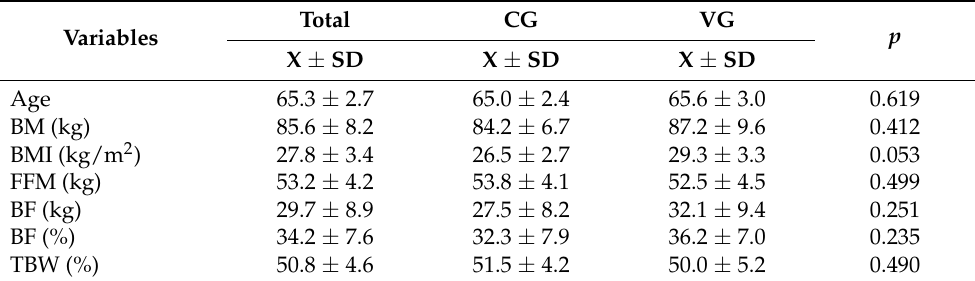
Table 1. Values of anthropometric parameters in the whole group and in the control (CG) and the examined (VG) groups before applying vibrotherapy.